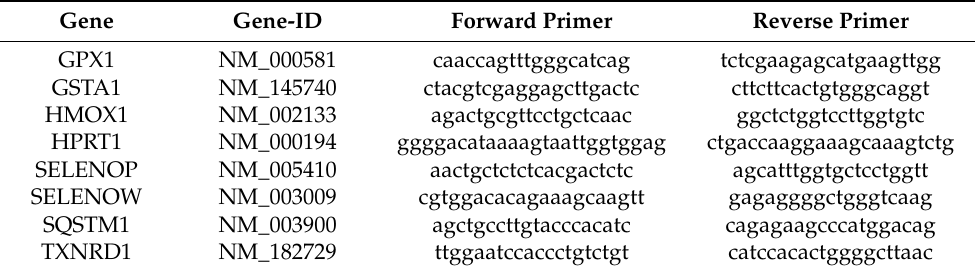
Table 1. Primers (5 (cid:48) -3 (cid:48) ) used for qRT-PCR